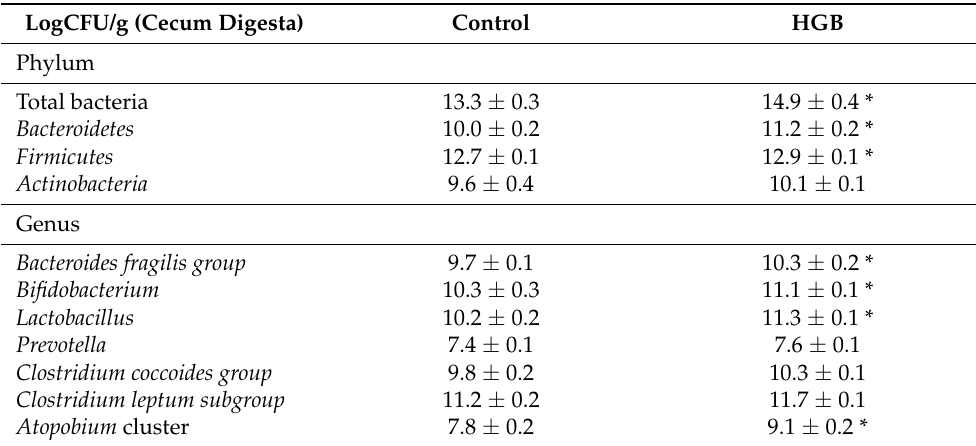
Table 1. Counts of the predominant bacterial groups in the cecum digesta between the control and HGB groups.